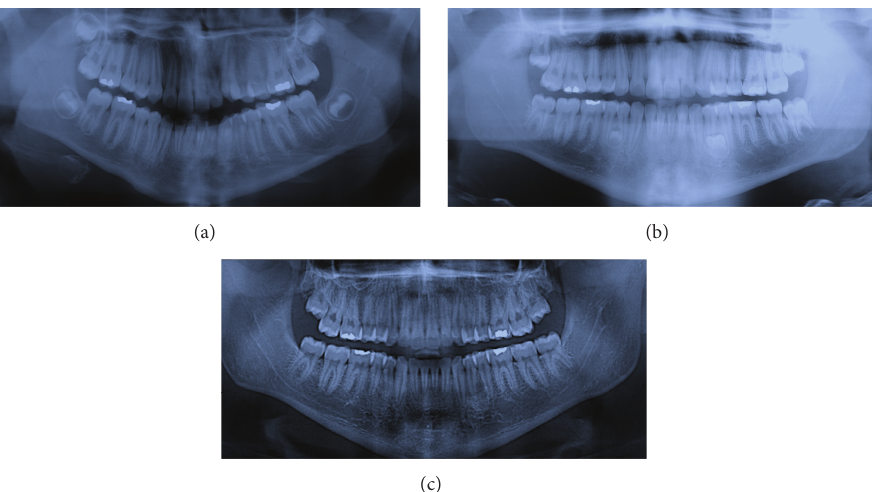
Figure 6: Case 4 radiography: before treatment 2011 (a), after treatment, ST in regions 3.4–3.5 and 4.4–4.5, 2014 (b), and after extraction of ST 2014 (c).